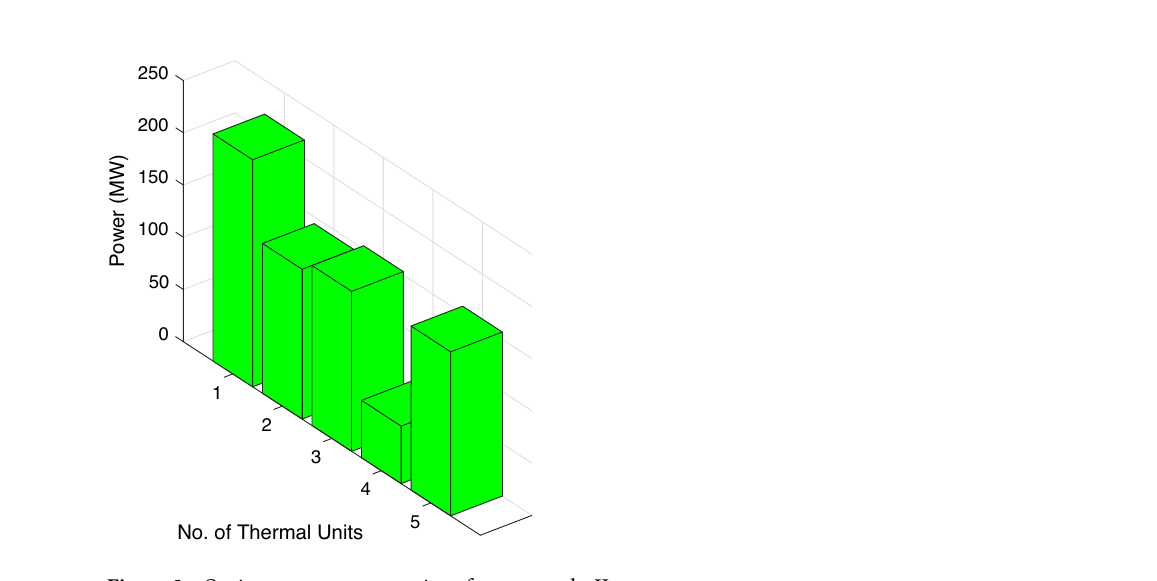
Figure 9. Optimum power generations for case study-II.